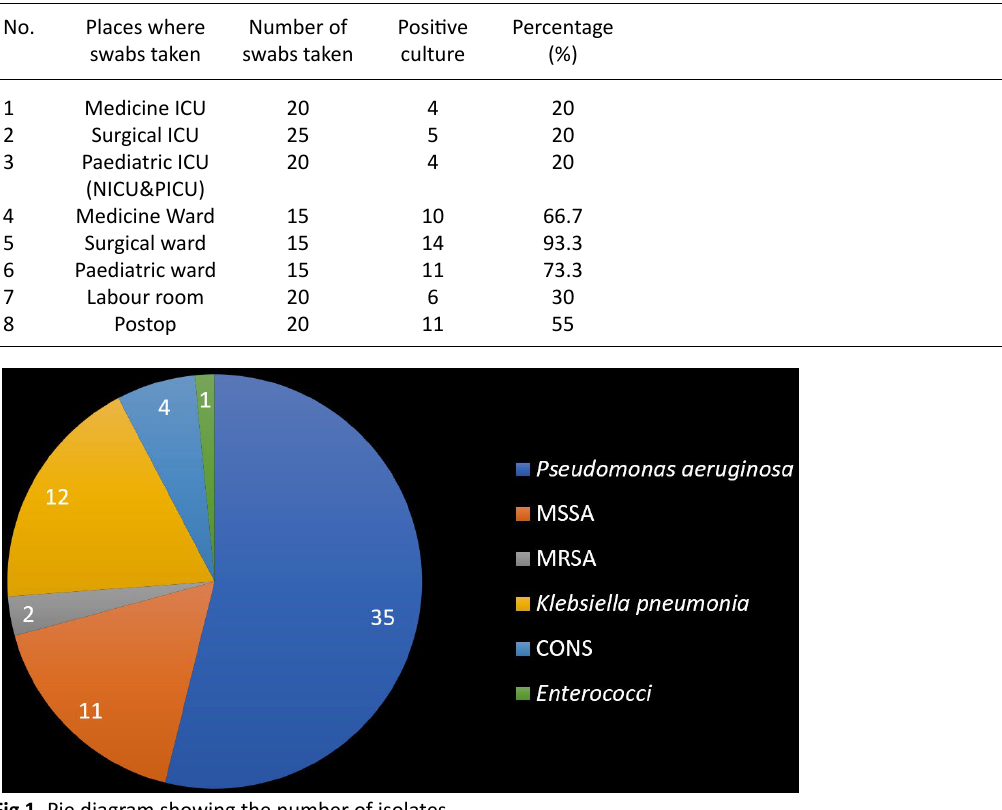
Table 1. Positive Bacterial growth in different areas of the hospital No.